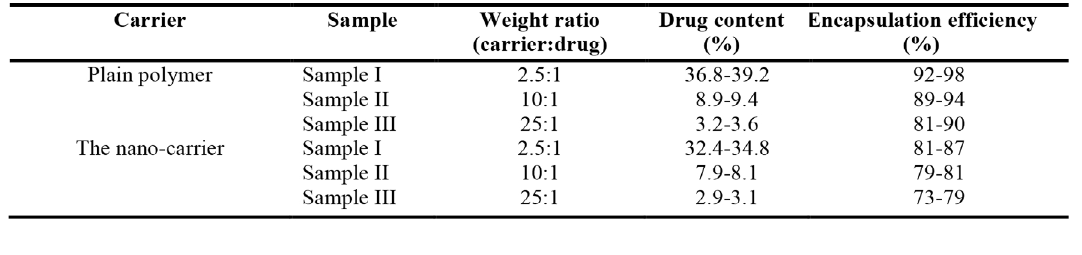
Table 3. Loading characteristics of the plain polymer and the